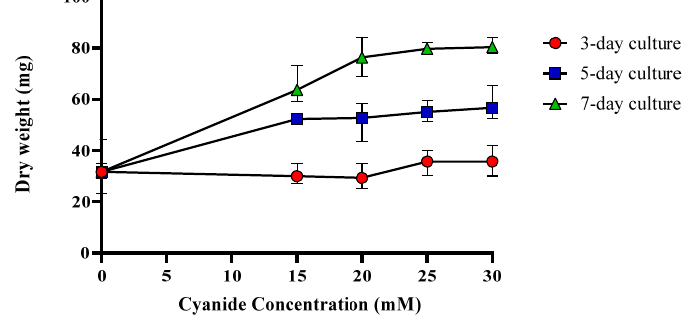
Figure 2. T. harzianum dry weight in cyanide-containing media (15, 20, 25, and 30 mM cyanide). Table 2. Percentage of cyanide degradation by T. harzianum in different cultures with four cyanide concentrations.